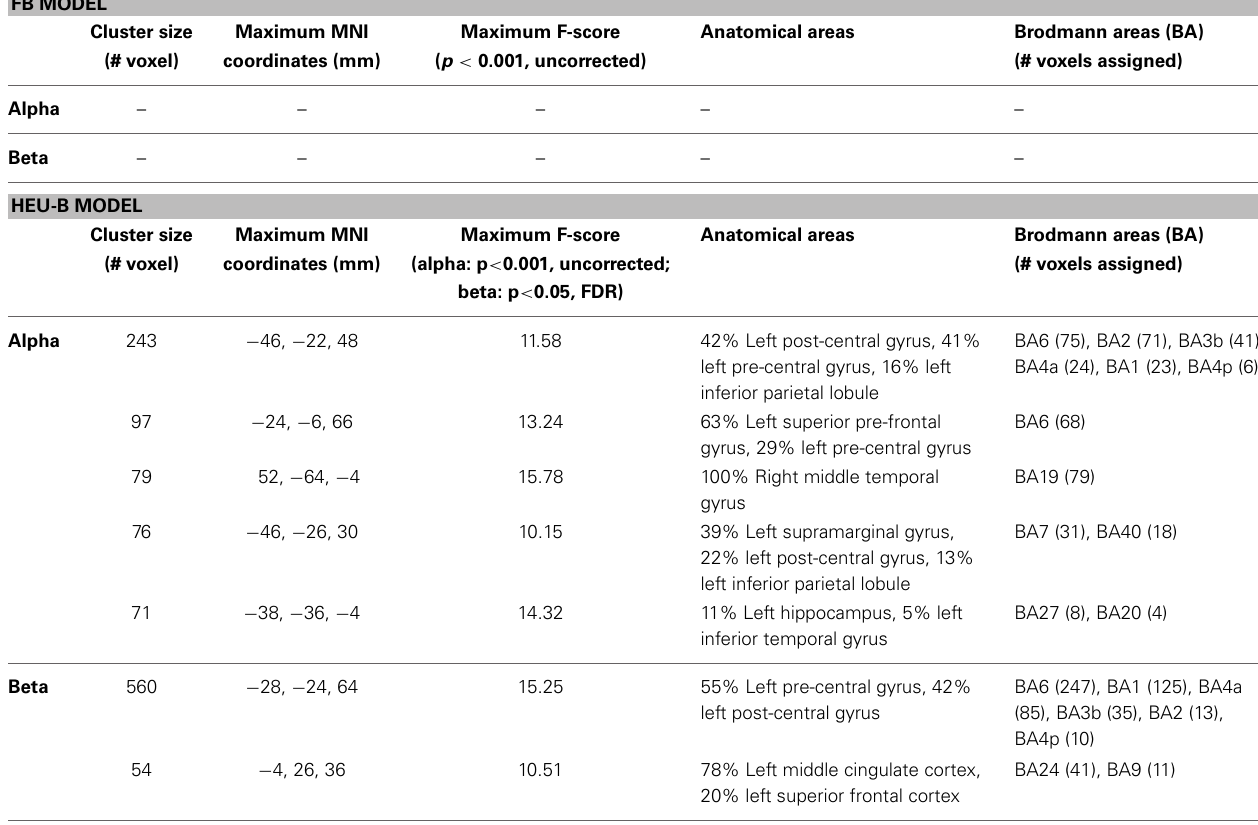
Table 3 | Global models